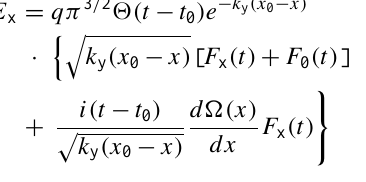
(Fig. 5). There are two contributions in E x . The first is F x (t) + F 0 (t) which behaves similar to the E y component: beating with decaying amplitude. The second one is propor- tional to F x (t) . It represents the oscillation with the local fre- quency (cid:127)(x) on the given magnetic shell and grows with time as the square root of time. The amplitude of the E x tends to some constant value, as is seen also from Fig. 4,